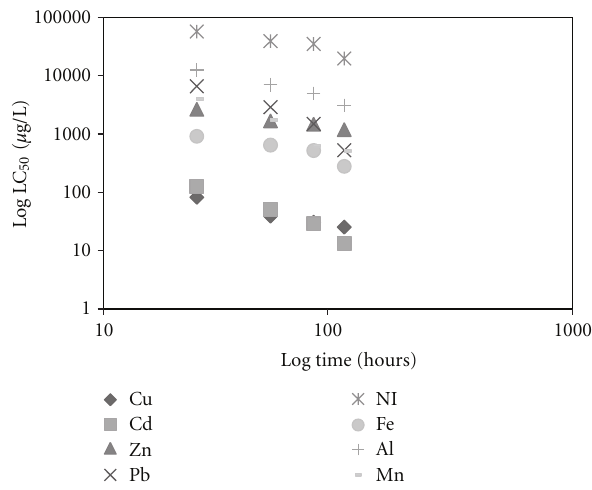
Figure 1: The relationship between median lethal concentration (LC 50 ) and exposure times for S. major .